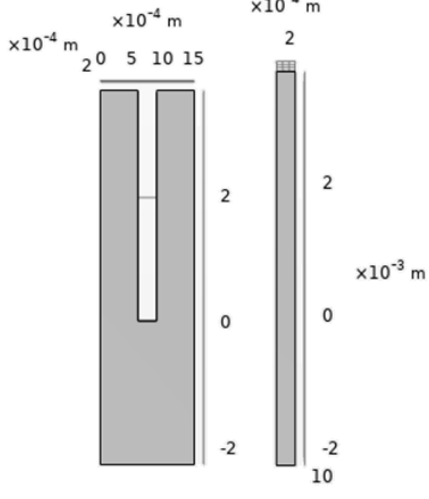
Figure 4. The established QCTF model.